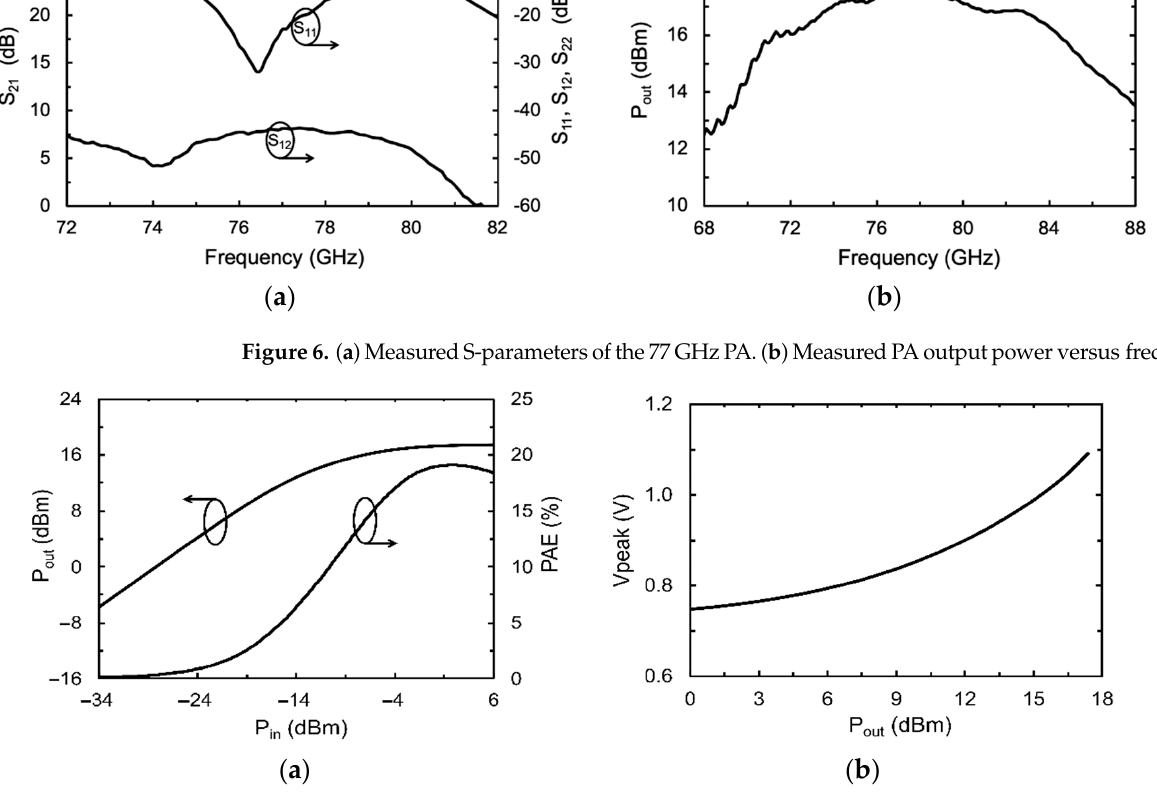
Figure 6. ( a ) Measured S-parameters of the 77 GHz PA. ( b ) Measured PA output power versus fre- quency.